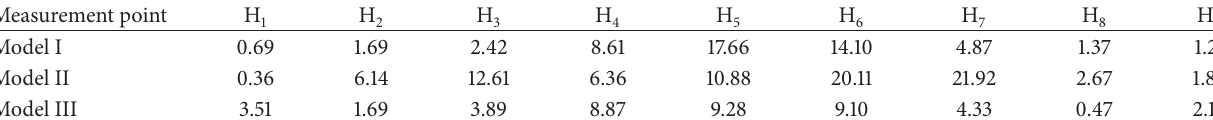
–H for base excitation at 𝑓 1 (mm/s). 1 9